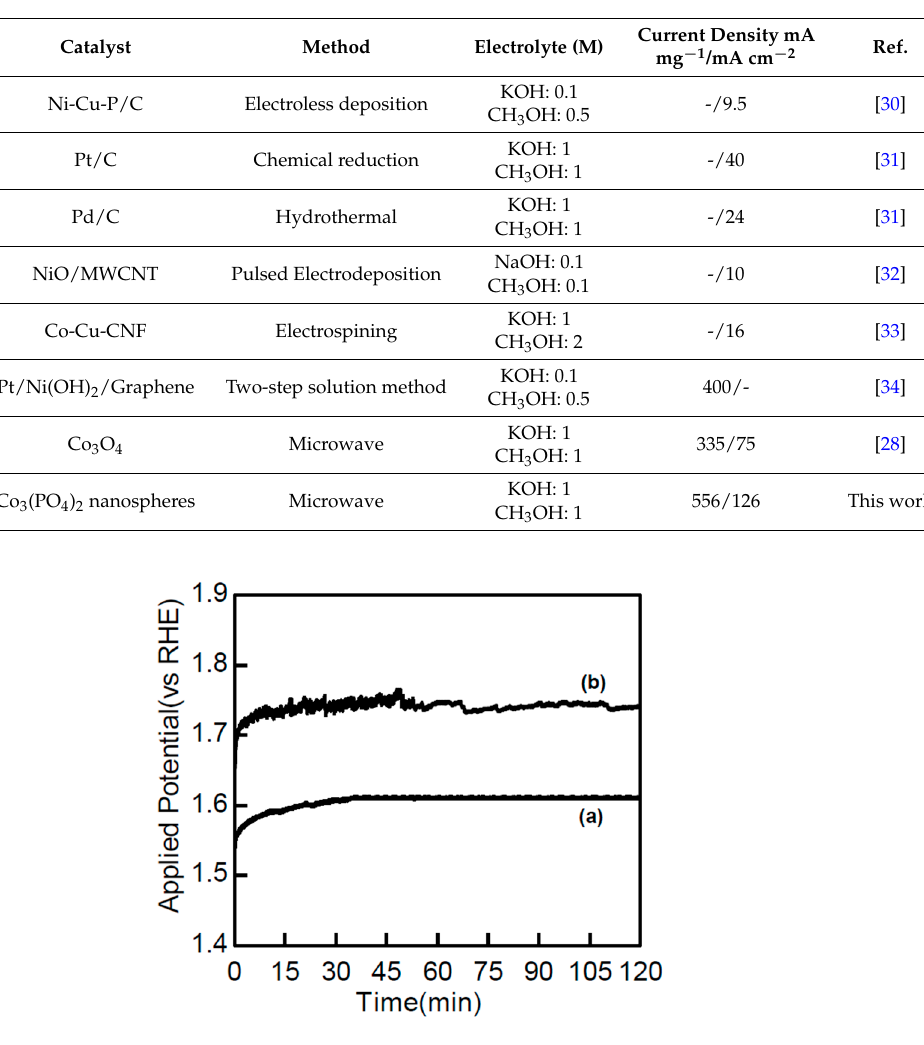
Figure 10. Chronopotentiometry curves of methanol oxidation over a Co 3 (PO 4 ) 2 nanosphere-modified electrode under constant current densities of 25 (a) and 75 mA/cm 2